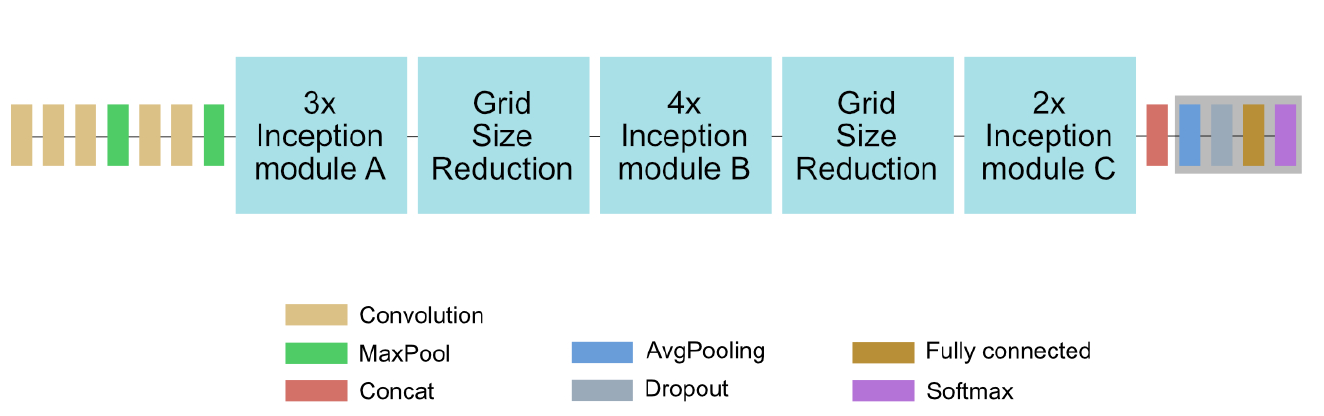
Figure 4. The InceptionV3 Net: Most layers of InceptionV3 are organized in so-called inception modules (see [23]). These inception modules compute multiple convolutions that are concatenated and used as the output of the module. The output of the last inception module before the classification layers (shaded gray) is used for feature extraction in our